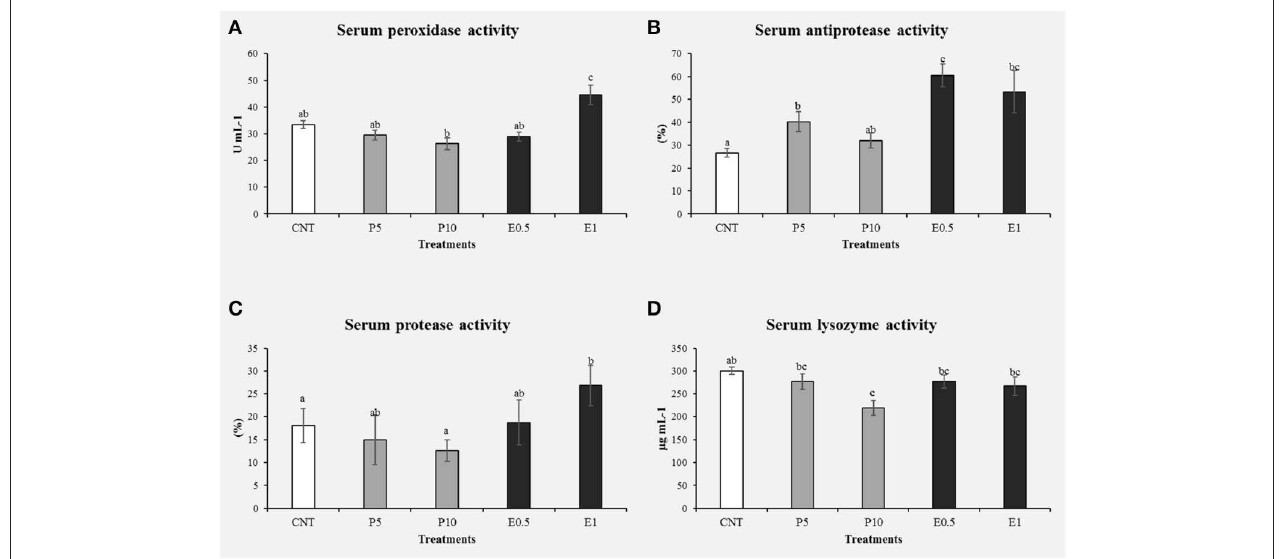
FIGURE 5 | Immune related parameters determined in the serum of S. aurata fed with honey bee pollen (HBP) and its SFE extract (CNT: control, P5: pollen 5%, P10: pollen 10%, E0.5: SFE 0.5% and E1: SFE 1%): peroxidase activity (U mg prot − 1) (A) , antiprotease activity (%) (B) , protease activity (%) (C) , and lysozyme activity (U mg prot − 1) (D) . Values are the mean ± SEM ( n = 9). Statistical differences ( P < 0.05) between groups are indicated by different